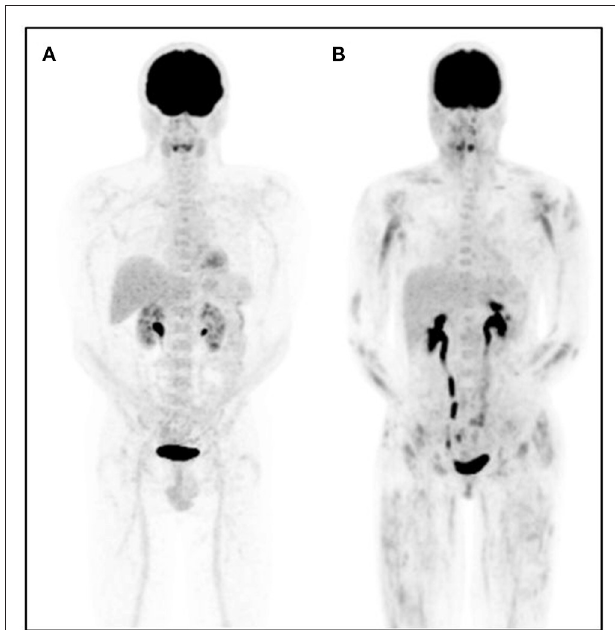
FIGURE 2 | Representative [ 18 F]FDG-PET images in a control patient and a patient with dermatomyositis. [ 18 F]FDG-PET maximum intensity projection image of a subject with physiologic [ 18 F]FDG biodistribution (A) and a representative patient with dermatomyositis (B) . Proximal and symmetrical heterogeneous [ 18 F]FDG muscle uptake is observed in patient (B)